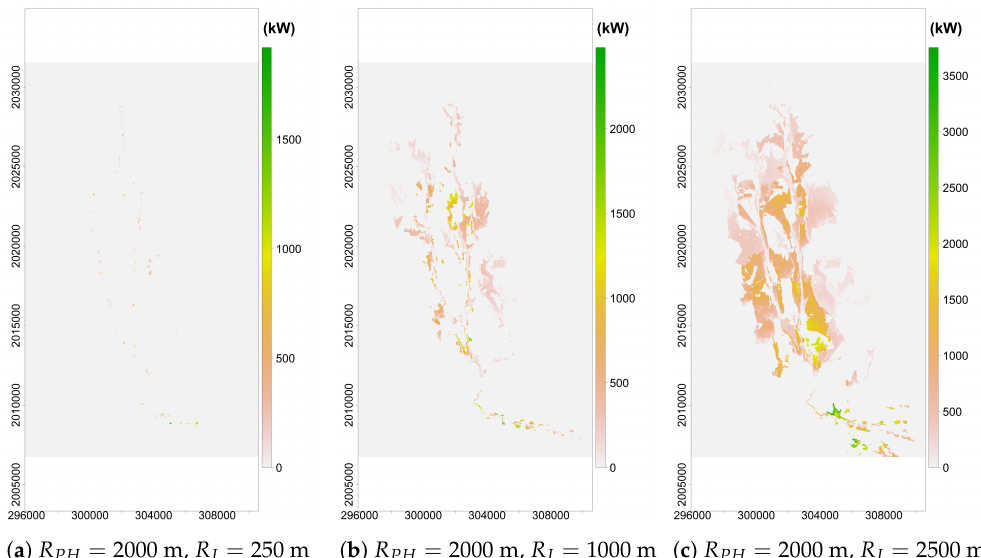
Figure 9. Hydropower maps for fixed maximum penstock’s length R PH = 2000